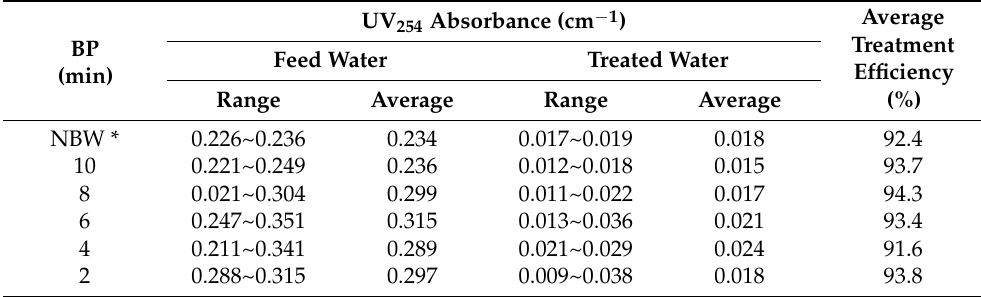
Table 7. Water quality and treatment efficiency of DOM (UV 254 absorbance) in the combined process of tubular alumina MF (NCMT-7231) and PP beads for the influence of water backwashing period. UV 254 Absorbance (cm − 1 BP (min)